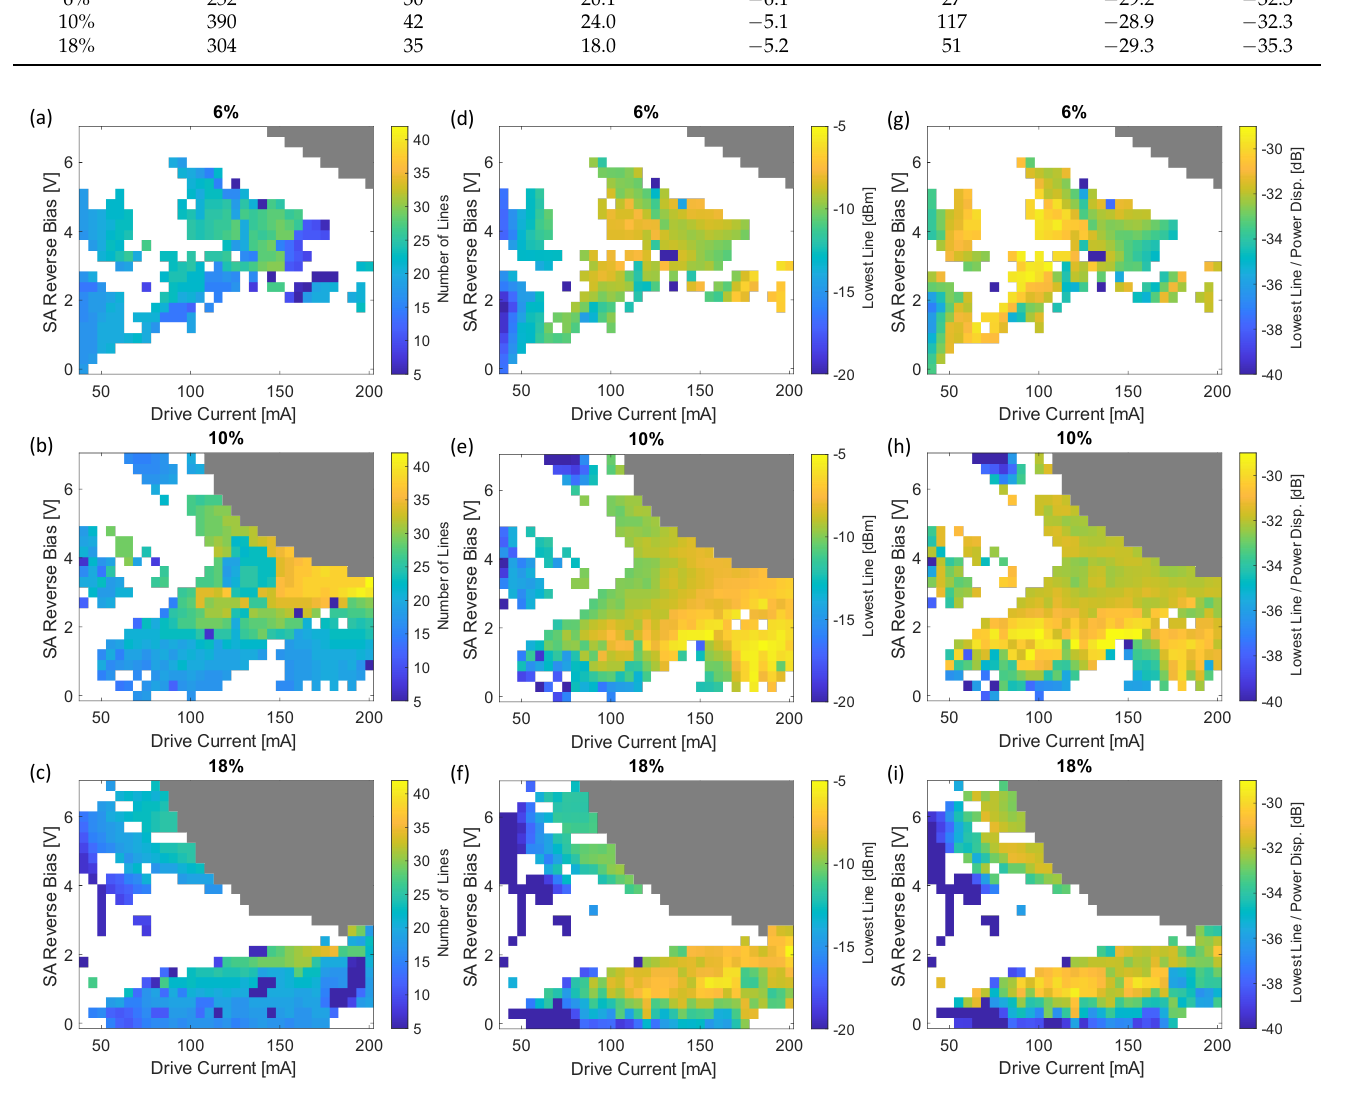
Figure 4. Color-coded plot of the 6 db optical bandwidth ( a – c ), measured in the number of 60 GHz spaced comb lines, power of the lowest line of a contiguous 20-line comb ( d – f ), and the wall plug efficiency of the lowest comb line ( g – i ) for total saturable absorb lengths of 6%, 10%, and 18% of the cavity length. Gray regions were not tested to avoid risk of device